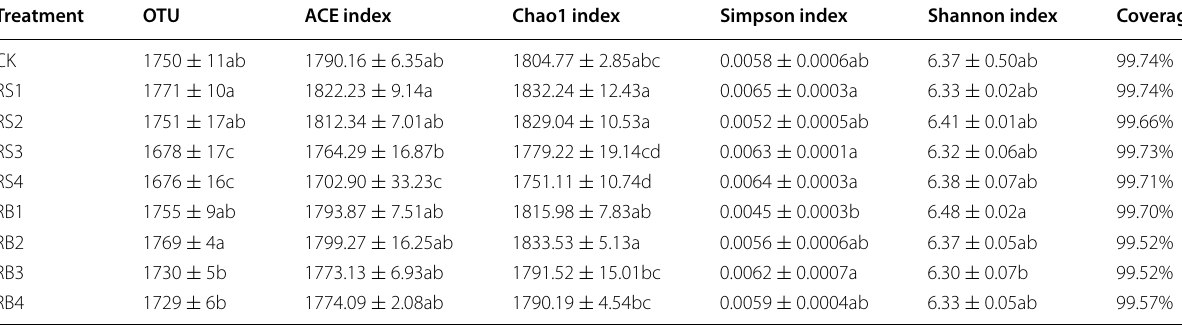
Table 2 Soil bacterial community alpha index in different treatments